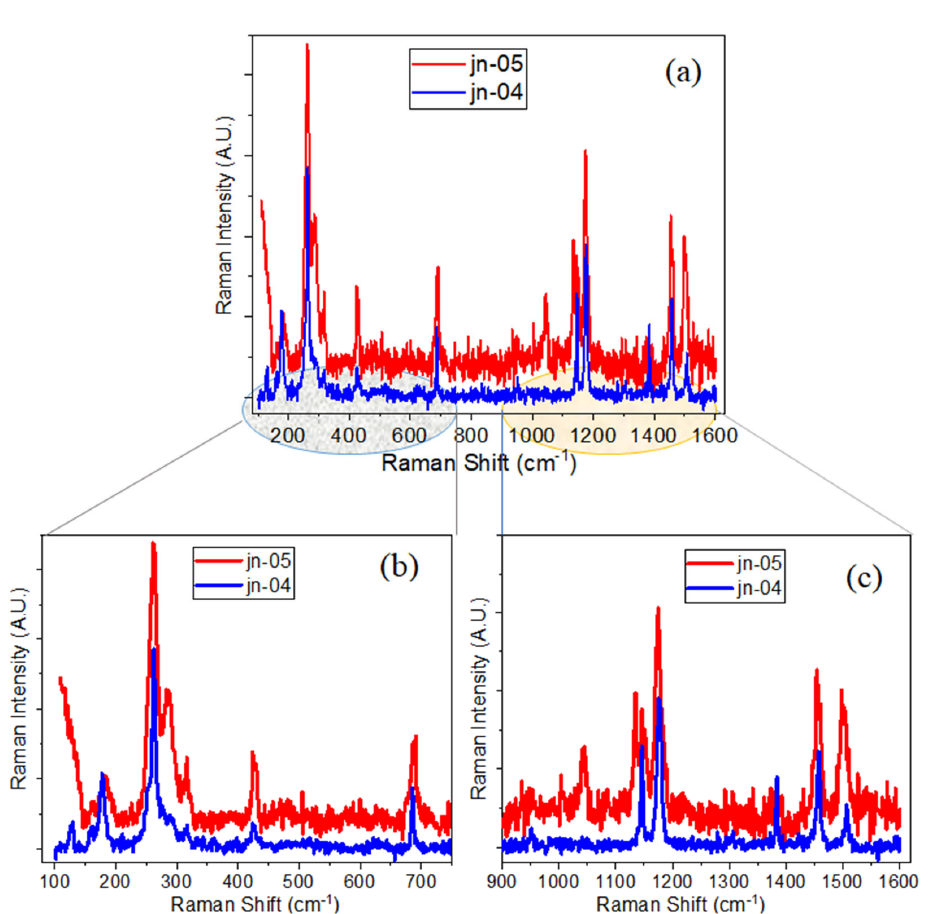
Figure 6. Raman spectra of ( a ) ZIF ‐ 67 ‐ 1 powder sample (blue) and ZIF ‐ 67 ‐ 1@MCG (red); ( b , c )—show the more detailed spectra in lower and higher frequency ranges.